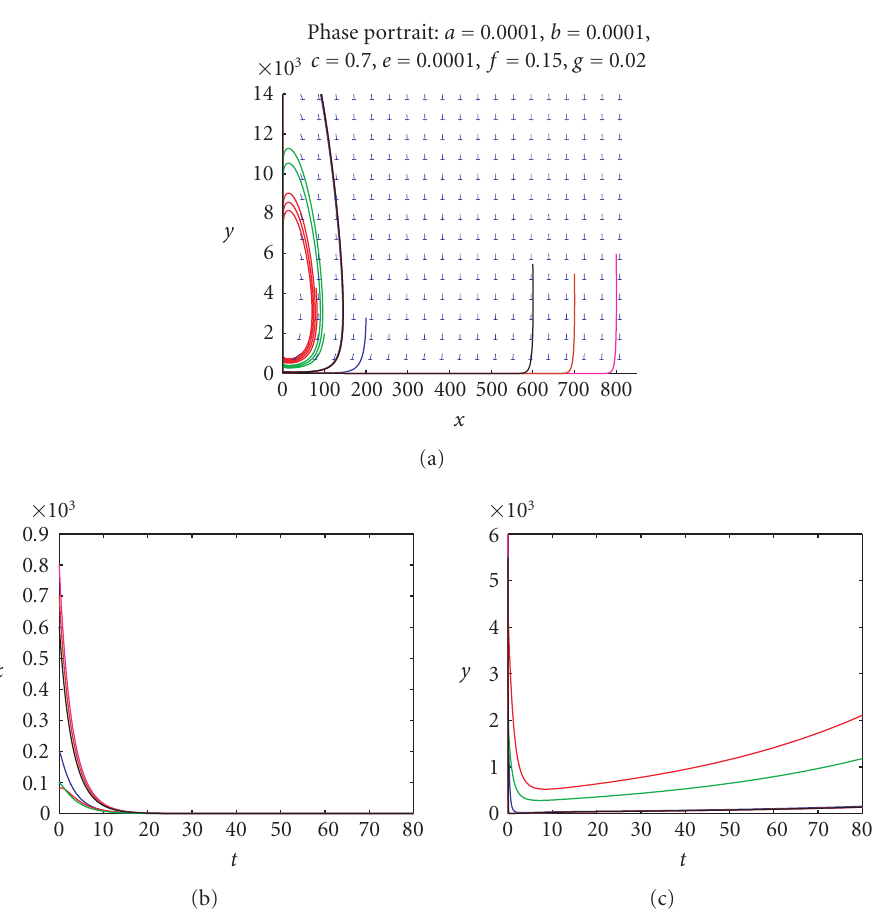
Figure 3.17. The e ff ects of both military and nonviolent actions are illustrated here for c < 1. The fixed point is at x 0 ≈ 14, y 0 ≈ 3013, and the trajectories appear to reach the equilibrium point marginally faster than with only nonviolent intervention. All the parameters are the same for Figures 3.13(a), 3.14, 3.16, and 3.17, except for the values of b and e . A soliton-like behavior is observed from the phase